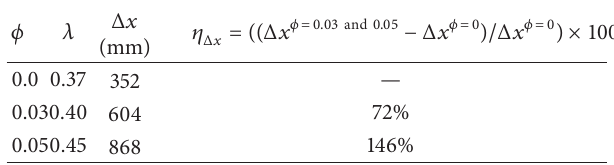
Table 2: Comparison of penetration length at certain time with nanoparticle